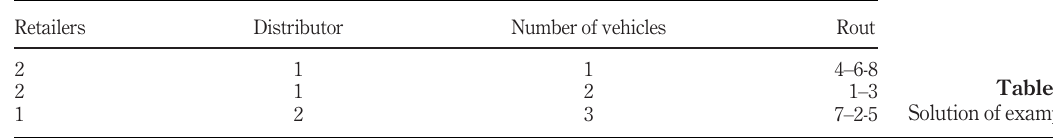
Table 2. Solution of